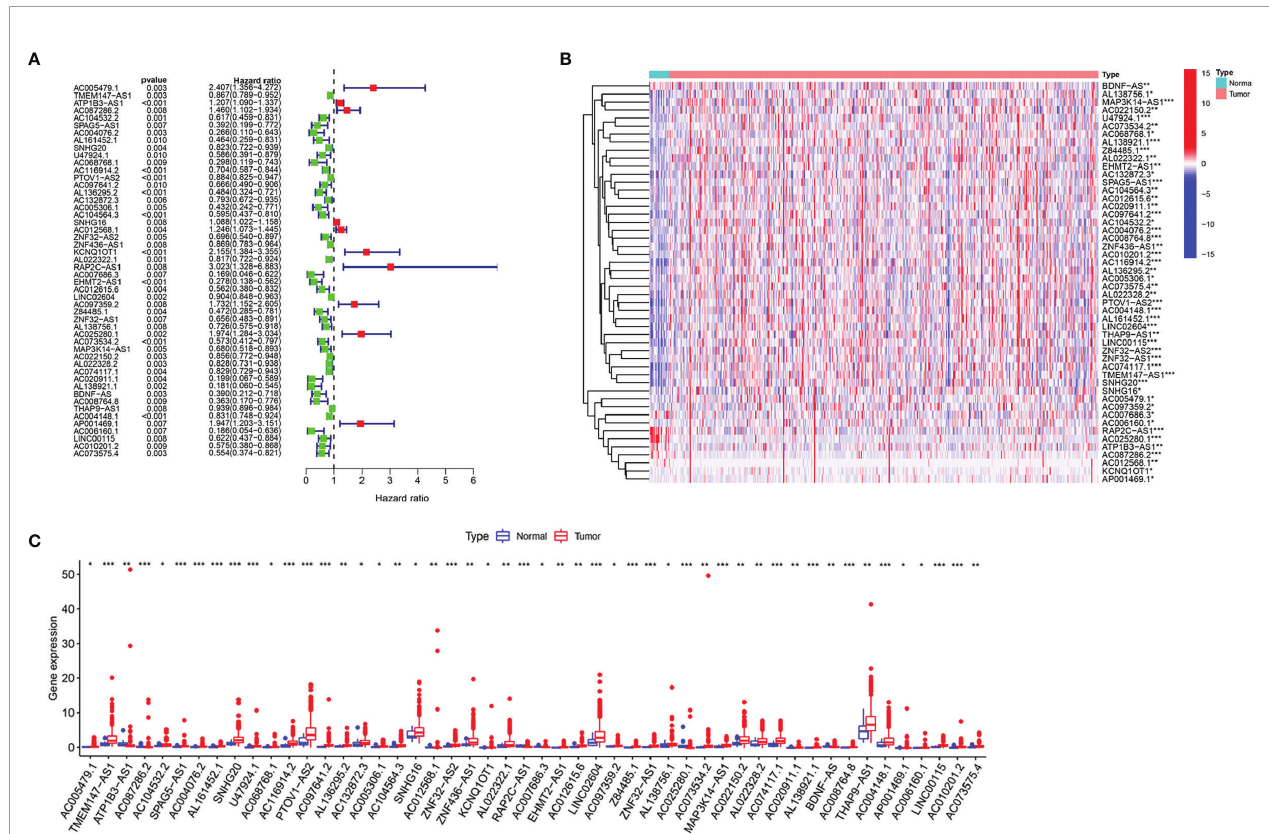
FIGURE 2 | The differences in the expression of m6A-related lncRNAs in the TCGA datasets. (A) Forest plot of the hazard ratio for m6A-related lncRNAs. (B, C) Heatmap (B) and expression levels (C) of 50 m6A-related lncRNAs in tumor and adjacent normal tissues. * P < 0.05, ** P < 0.01, and *** P <